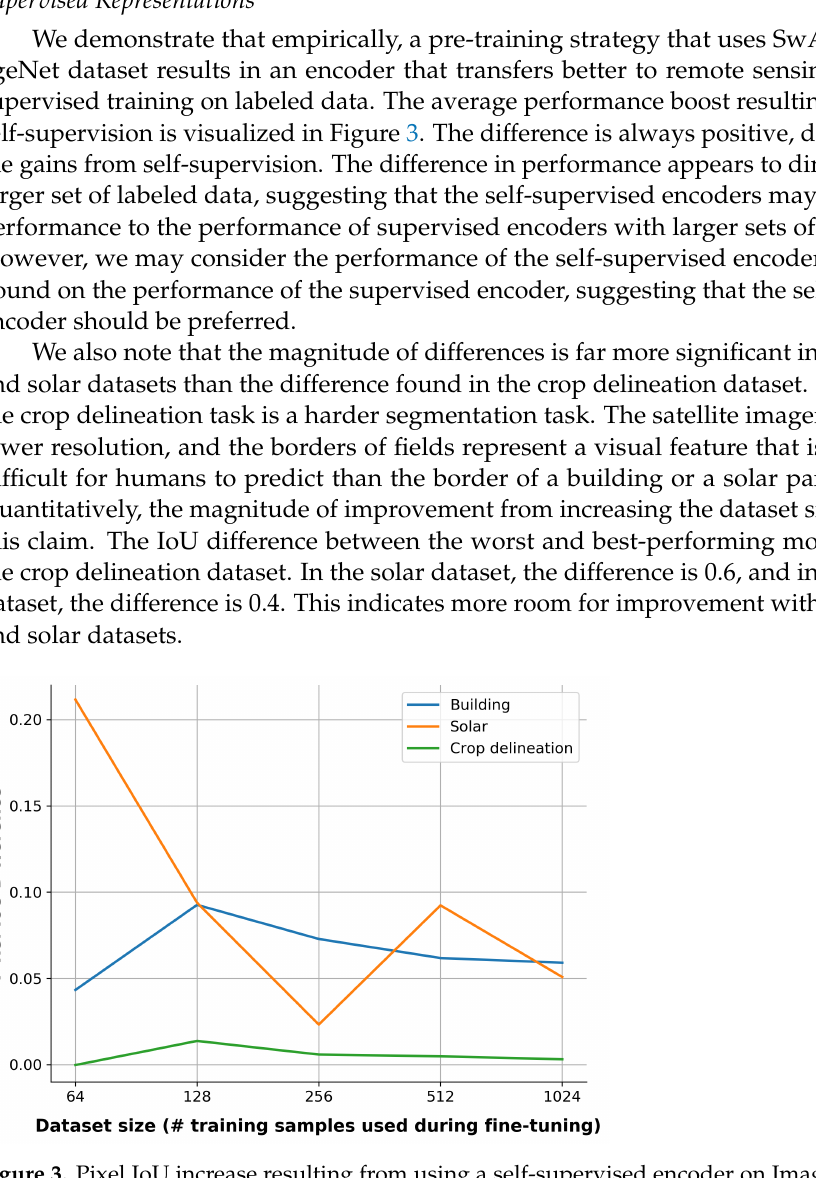
Figure 3. Pixel IoU increase resulting from using a self-supervised encoder on ImageNet over the supervised ImageNet